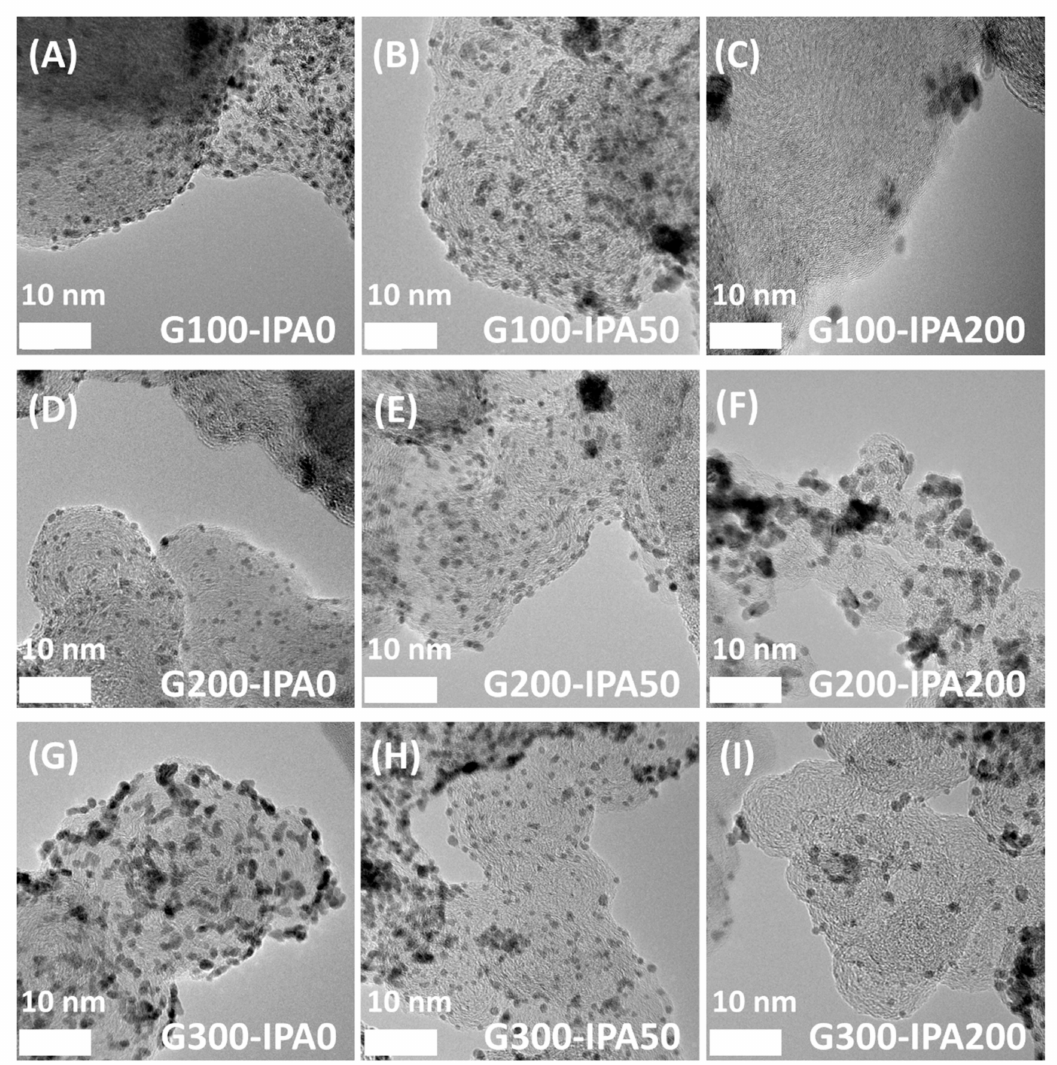
Figure 2. TEM images of ( A ) G100-IPA0, ( B ) G100-IPA50, ( C ) G100-IPA200, ( D ) G200-IPA0, ( E ) G200-IPA50, ( F ) G200-IPA200, ( G ) G300-IPA0, ( H ) G300-IPA50, and ( I ) G300-IPA200